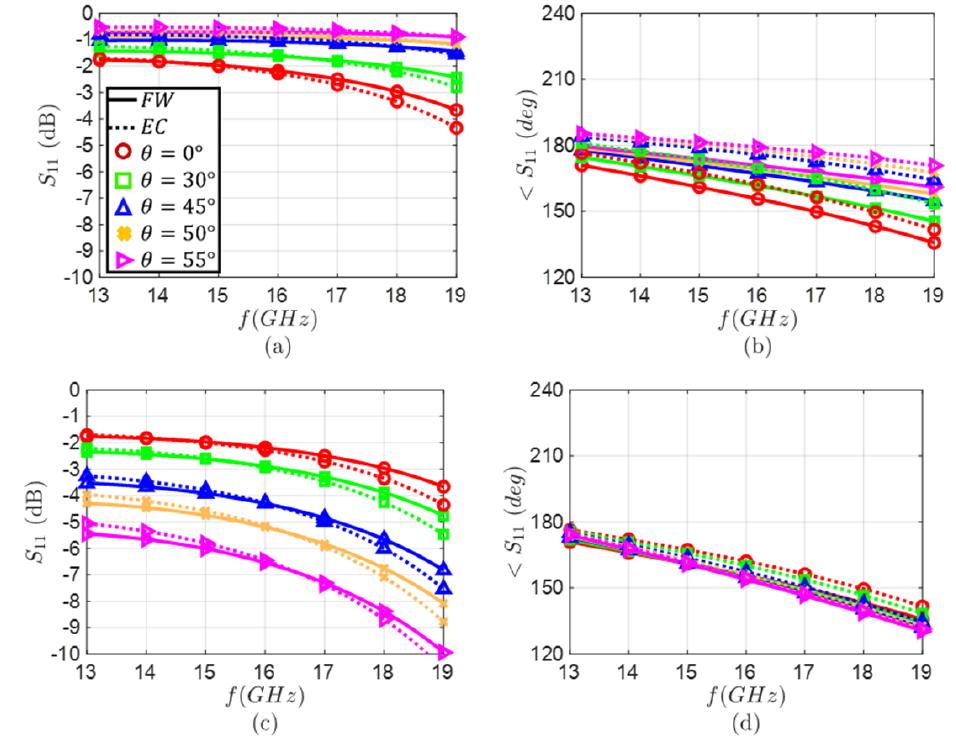
Figure 3. Reflection coefficient validation unloaded unit-cell: ( a , b ) H-plane and ( c , d ) E-plane , magni- tude and phase, respectively.